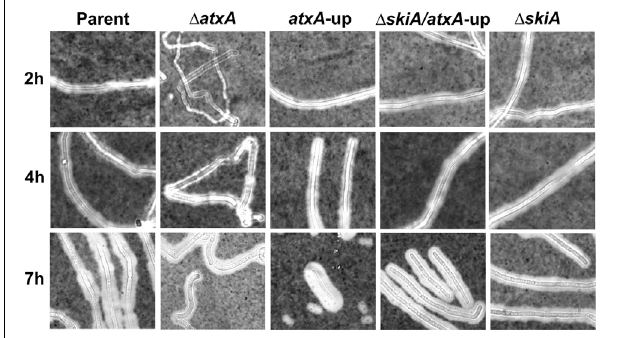
FIGURE 5 | Capsule production of B. anthracis parent and mutant strains in toxin-inducing conditions (CACO 3 + 5% CO 2 ). Qualitative analysis of capsule production using India ink exclusion assays. These data are representative of three separate experiments.